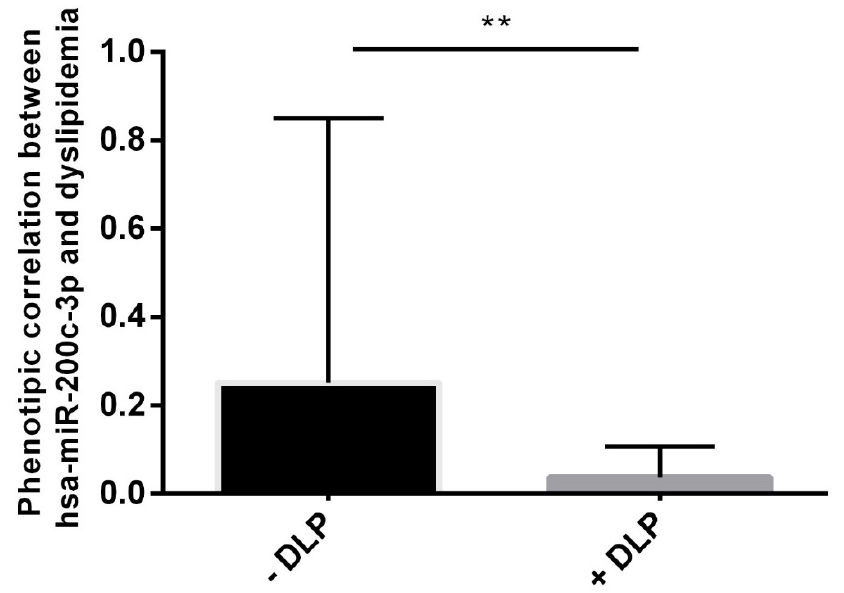
Figure 9. Phenotypic correlation of has-miR-200c-3p and dyslipidemia in the CAD group. -DLP: CAD not affected by dyslipidemia. +DLP: CAD affected by dyslipidemia. t -test. ** p -value < 0.01. Expression data are represented as the mean and SD.